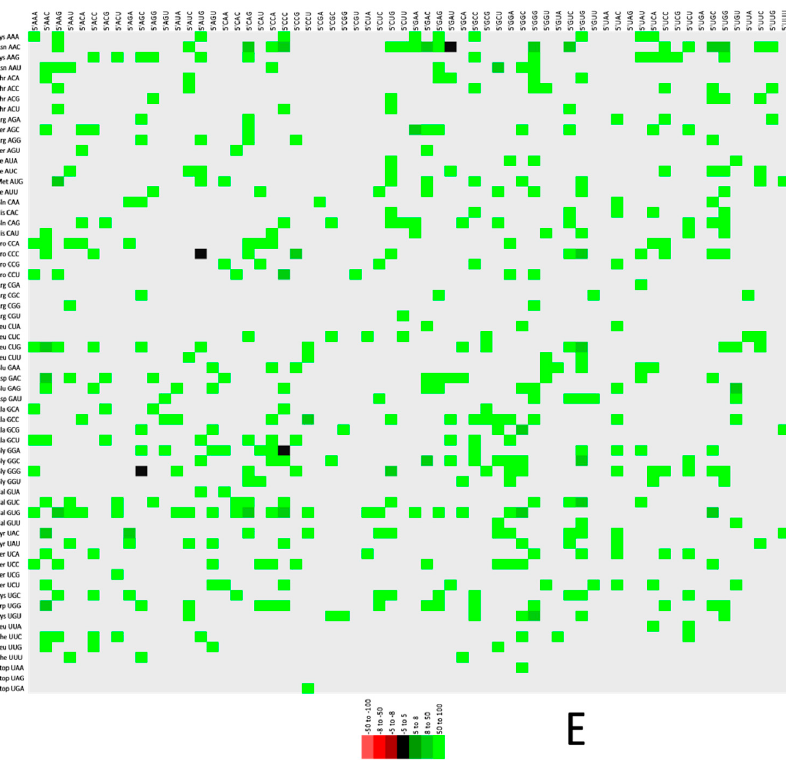
Figure 5. Codon context analysis for ( A ) ACE2, ( B ) BMAL1, ( C ) CD147, ( D ) FURIN, and ( E ) TMPRSS2 genes. The green color shows the preferred codon pair, while the red color represents the rejected codon pairs. Statistically insignificant values are expressed as black. The grey color indicates unrepresented codon pairs.